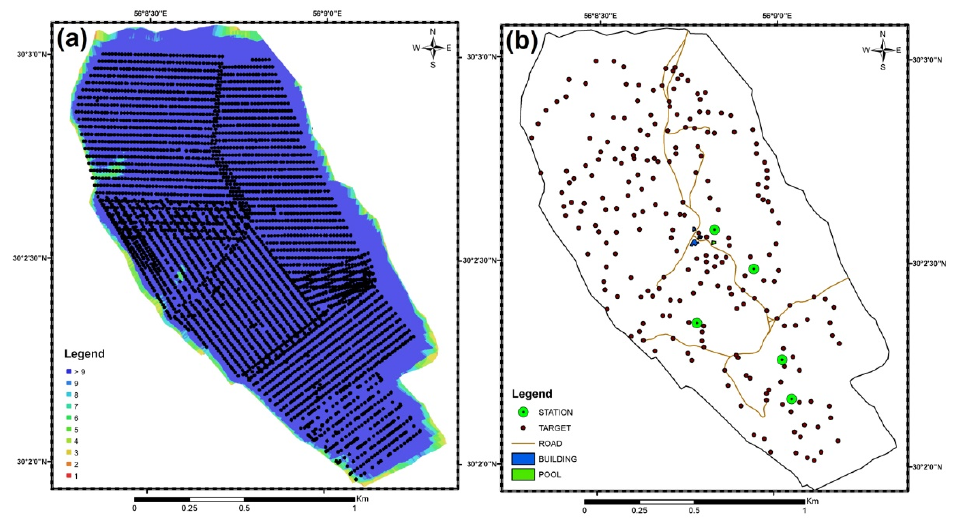
Figure 3. ( a ) Camera locations and image overlap, and ( b ) distribution of TGCPs in the study area.